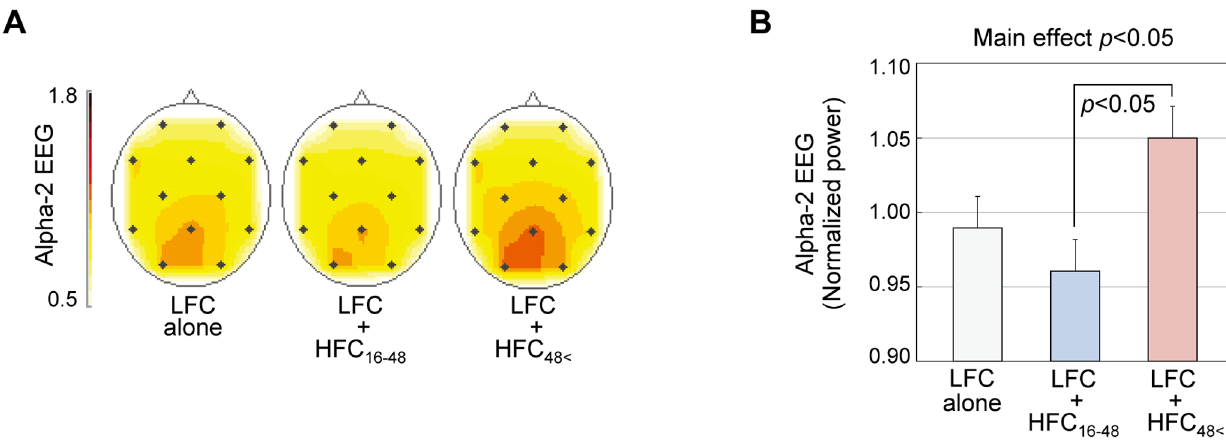
Figure 4. Results of Experiment 1: broad examination of frequency dependency of the hypersonic effect. A: Scalp distribution of electroencephalographic activity during application of different HFC frequencies. To overview the spatial distribution of the equivalent potential of alpha2 frequency band (10–13 Hz) of EEGs, colored contour line maps were constructed by using 2,565 scalp grid points computed by linear interpolation and extrapolation of alpha2 components from 12 electrodes [33,34]. Darker red indicates higher alpha2. Note that the alpha2 in the occipital region changed depending on the frequency of the HFC. B: Mean ( + SE) value of Alpha-2 EEGs. Potential of alpha2 frequency band recorded from 7 electrodes in the centro-parieto-occipital region (C3, C4, T5, Pz, T6, O1 and O2) for the last 100 sec of sound application was averaged across all subjects. Analysis of variance (ANOVA) revealed the main effect of HFC to be significant, and Tukey’s post-hoc test found significant difference between [LFC + HFC 16-48 ] and [LFC + HFC 48 , ].